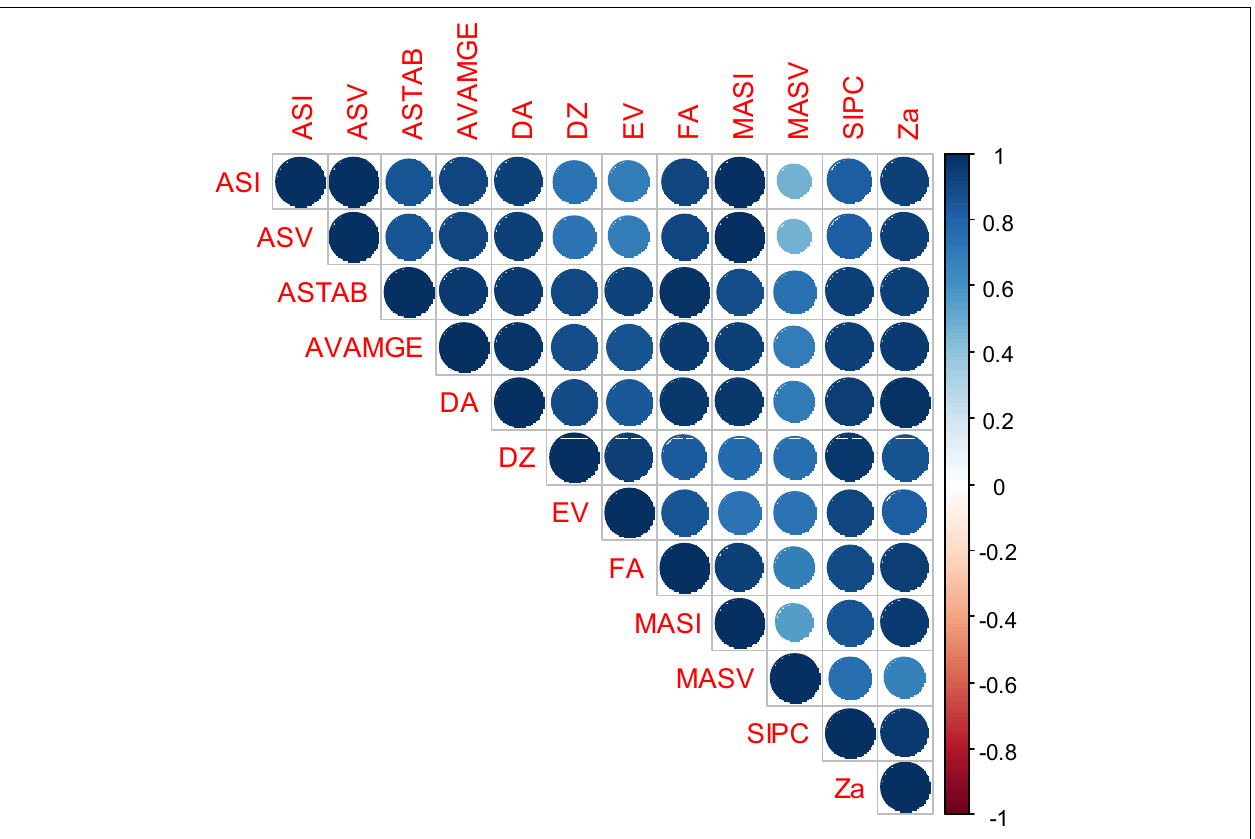
FIGURE 5 | Spearman’s rank correlation among various stability and simultaneous selection indices estimated for grain yield data of 60 finger millet genotypes evaluated under six test environments. AMGE, sum across environments of genotype × environment interaction (GEI) modeled by AMMI; ASI, AMMI Stability Index; ASV, AMMI stability value; ASTAB, AMMI-based stability parameter; AVAMGE, sum across environments of the absolute value of GEI modeled by AMMI; DA, Annicchiarico’s D parameter; DZ, Zhang’s D parameter; EV, averages of the squared eigenvector values; FA, stability measure based on fitted AMMI model; MASI, Modified AMMI Stability Index; MASV, modified AMMI stability value; SIPC, sums of the absolute value of the IPC scores; Za, absolute value of the relative contribution of IPCs to the